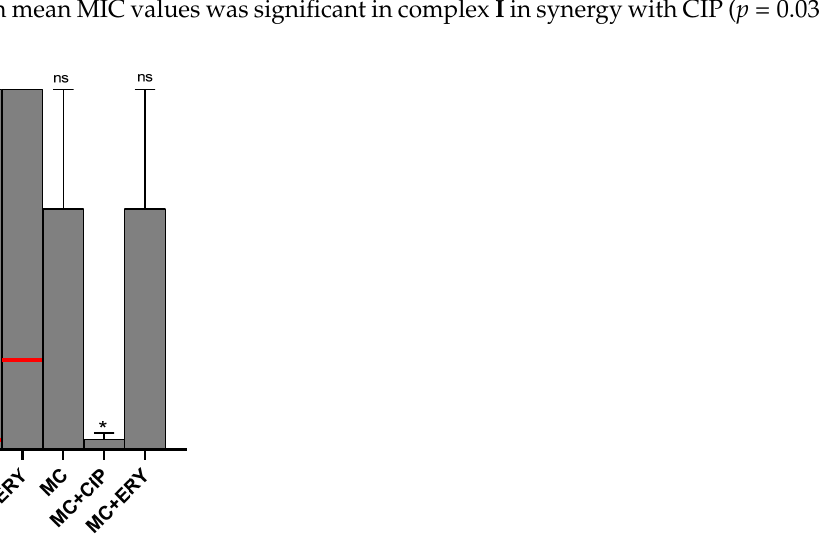
Figure 4. Effect of antimicrobial treatment with and without addition of complex I on three C. jejuni strains. * p < 0.05, ns p > 0.05, Mann–Whitney test in comparison with CIP and ERY alone. Red line: cut-off points for ERY and CIP according to CLSI (2021).